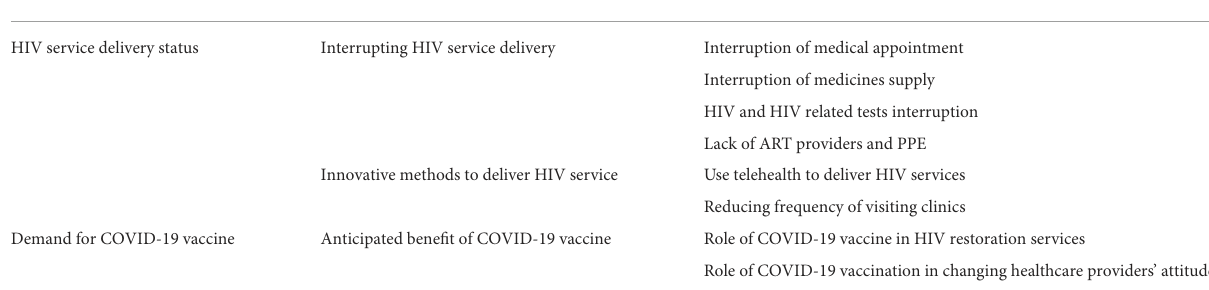
TABLE 2 List of themes and